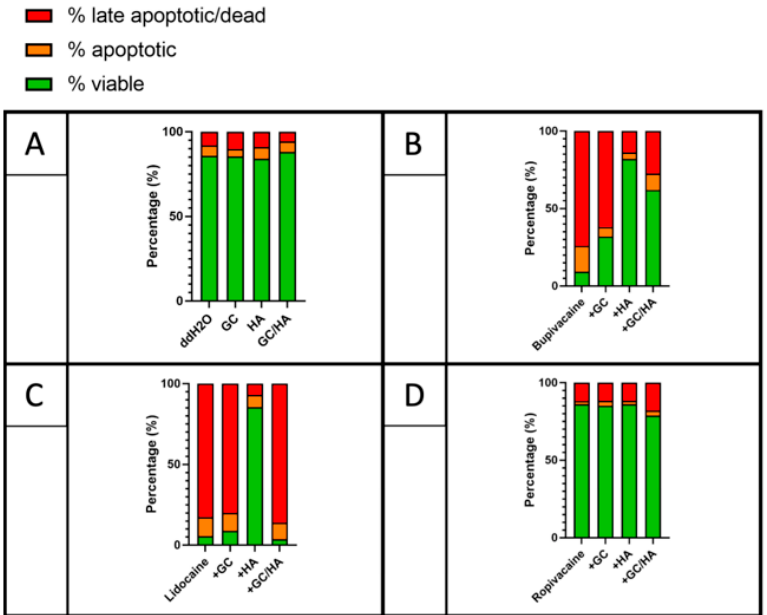
Figure 5. Distribution of viable, early, and late apoptotic chondrocytes in a single dose of the